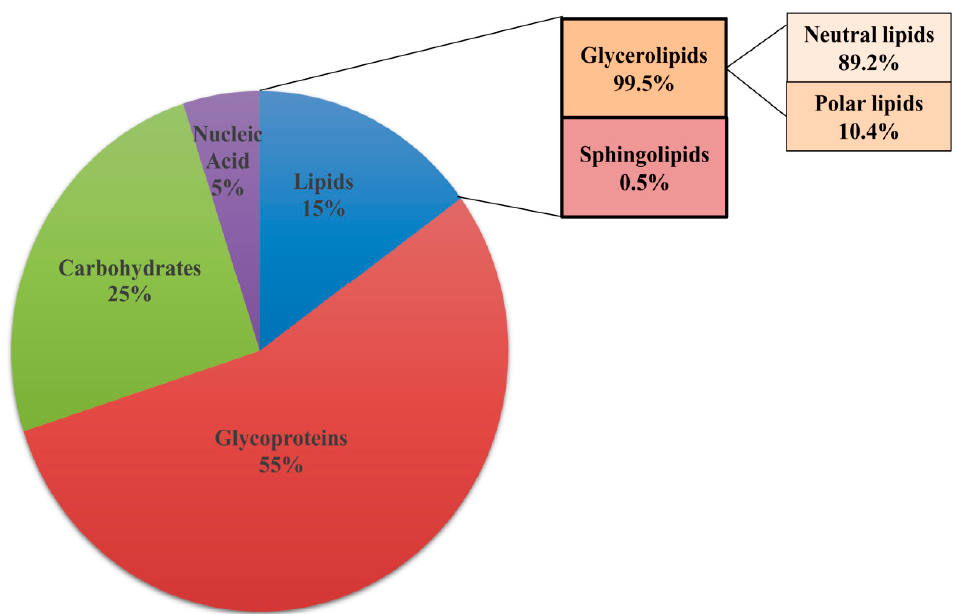
Figure 3. Composition of extracellular matrix (ECM) of biofilm. ECM of biofilm comprises of glycoproteins (55%), carbohydrates (25%), lipids (15%), and nucleic acid (5%). Glycerolipids (99.5%) and sphingolipids (0.5%) are the different classes of lipids present in the ECM. Glycerolipids contain a mixture of neutral lipids and polar lipids.